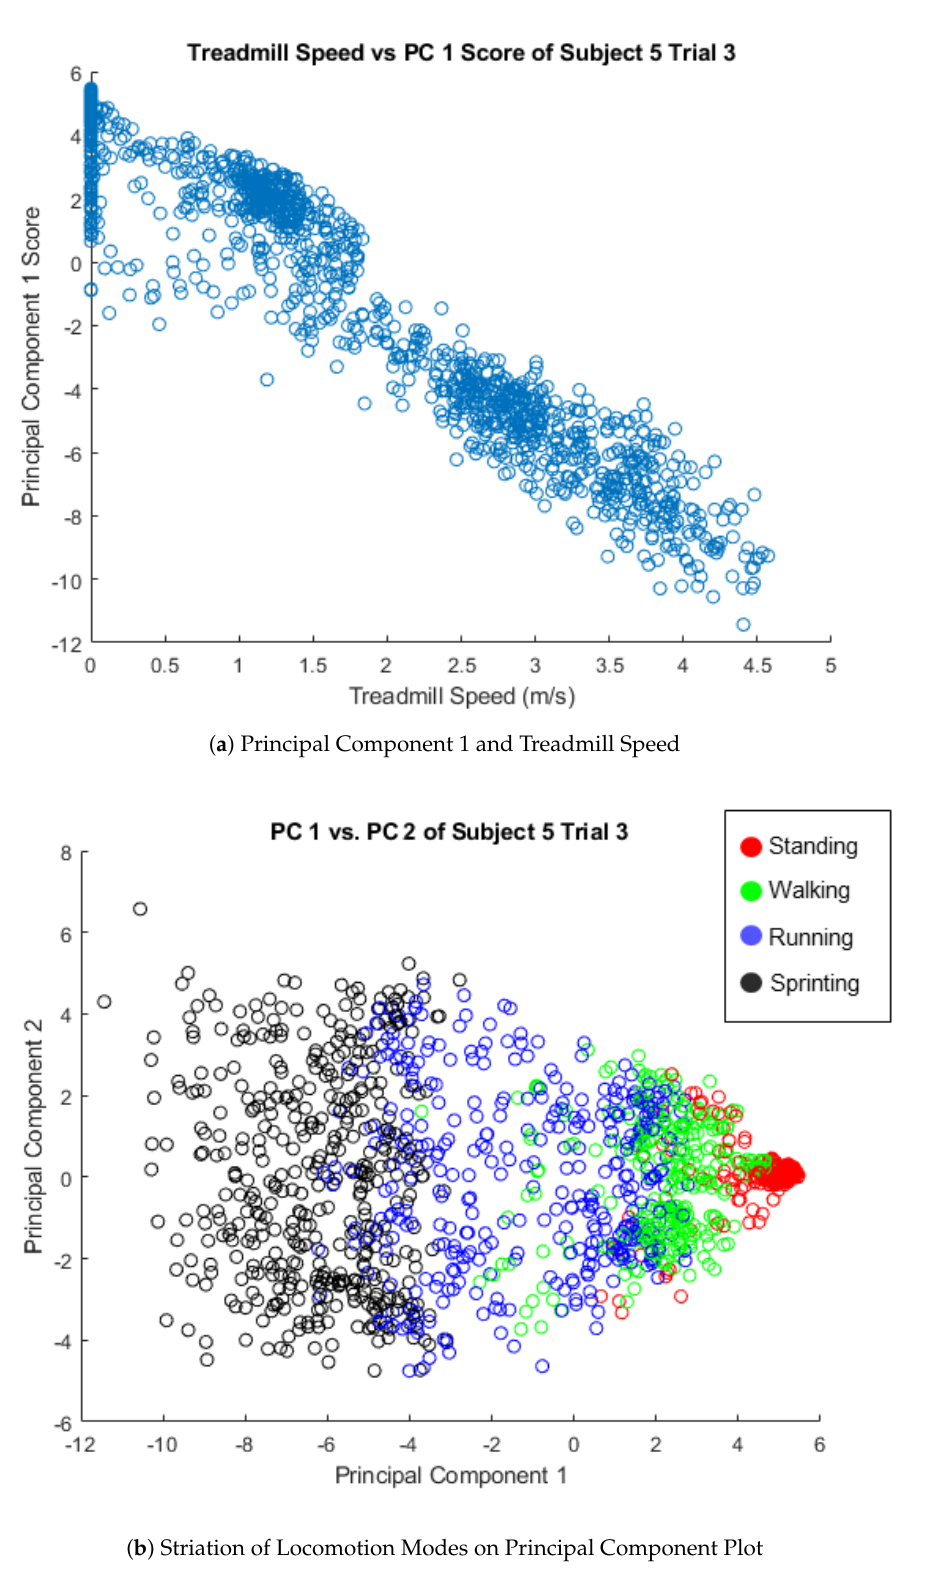
Figure 4. ( a ) A plot of the treadmill speed versus the scores of Principal Component 1. A high level of correlation between these two parameters can be seen with the strong negative slope. This correlation can be seen over all trials, but Subject 5 Trial 3 was selected as a representative case. ( b ) A plot of principal component scores where each data point is colored according to the mode of locomotion the subject was performing. A clear pattern emerges on the Principal Component 1